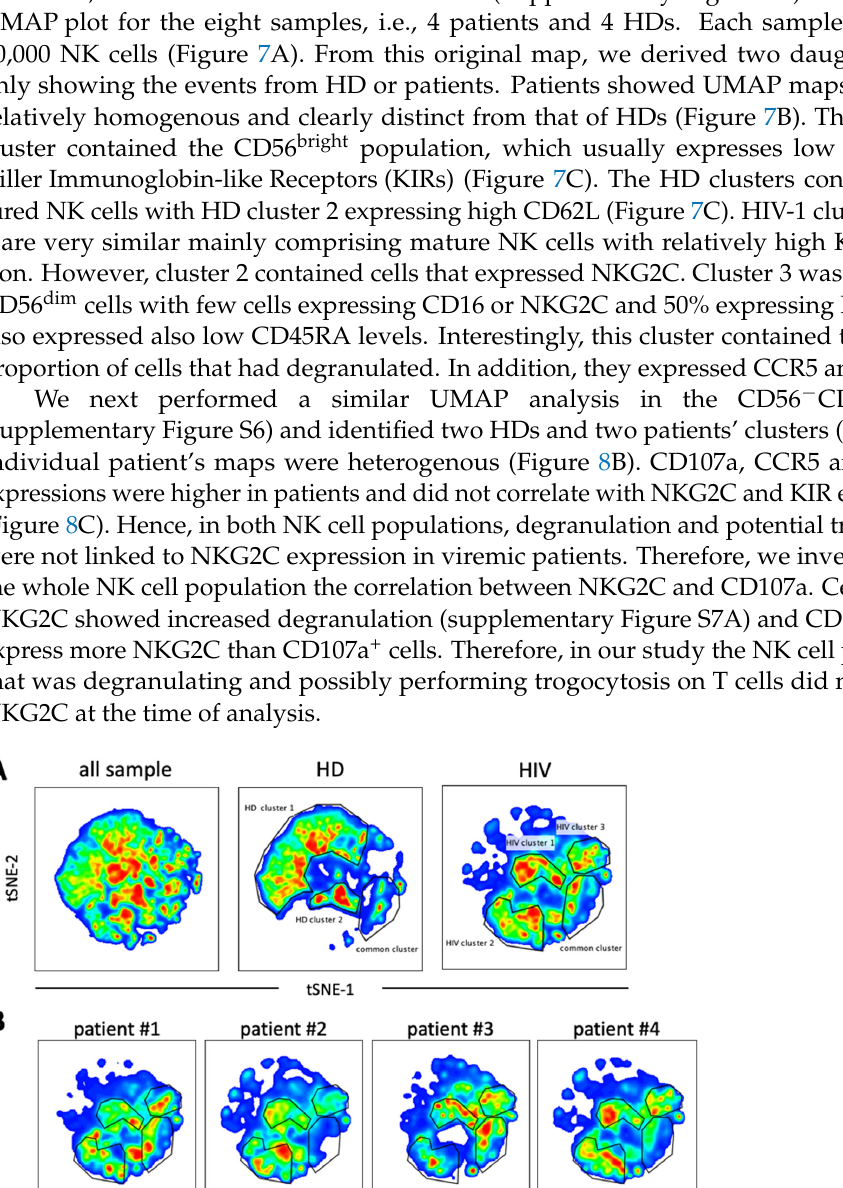
Figure 7. Cluster analysis on CD56 + NK cells by tSNE mapping in viremic patients. The tSNE map was built from 40,000 pre-gated CD56 + NK per sample (HD: n = 4, HIV-1: n = 4) based on 12 surface markers (supplementary Figure S5). ( A ) General tSNE map from all samples ( left ), HD samples ( middle ) and HIV-1 + samples ( right ) with identification of group-specific clusters. ( B ) tSNE replica showing clusters of each viremic HIV-1 patient. ( C ) Phenotypical characters of each cluster as iden- tified in ( A ). Bar graphs represent the proportion of positive cells for each of the surface markers from the whole of events analyzed in each cluster. We next performed a similar UMAP analysis in the CD56 − CD16 + cells (supplemen- tary Figure S6) and identified two HDs and two patients’ clusters (Figure 8A). Individual patient’s maps were heterogenous (Figure 8B). CD107a, CCR5 and CXCR4 expressions were higher in patients and did not correlate with NKG2C and KIR expressions (Figure 8C). Hence, in both NK cell populations, degranulation and potential trogocytosis were not linked to NKG2C expression in viremic patients. Therefore, we investigated in the whole NK cell population the correlation between NKG2C and CD107a. Cells lacking NKG2C showed increased degranulation (supplementary Figure S7A) and CD107a − cells express more NKG2C than CD107a + cells. Therefore, in our study the NK cell population